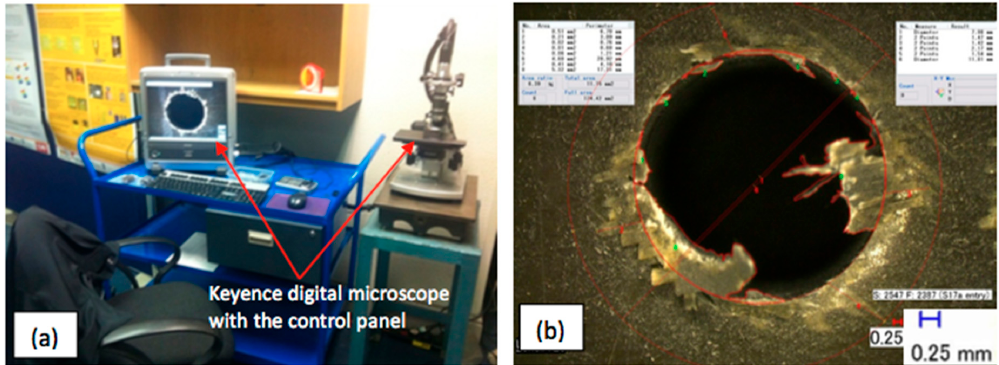
Figure 2. Evaluation of hole quality: ( a ) Keyence digital VHF-500X; ( b ) example of hole entry image analysis.